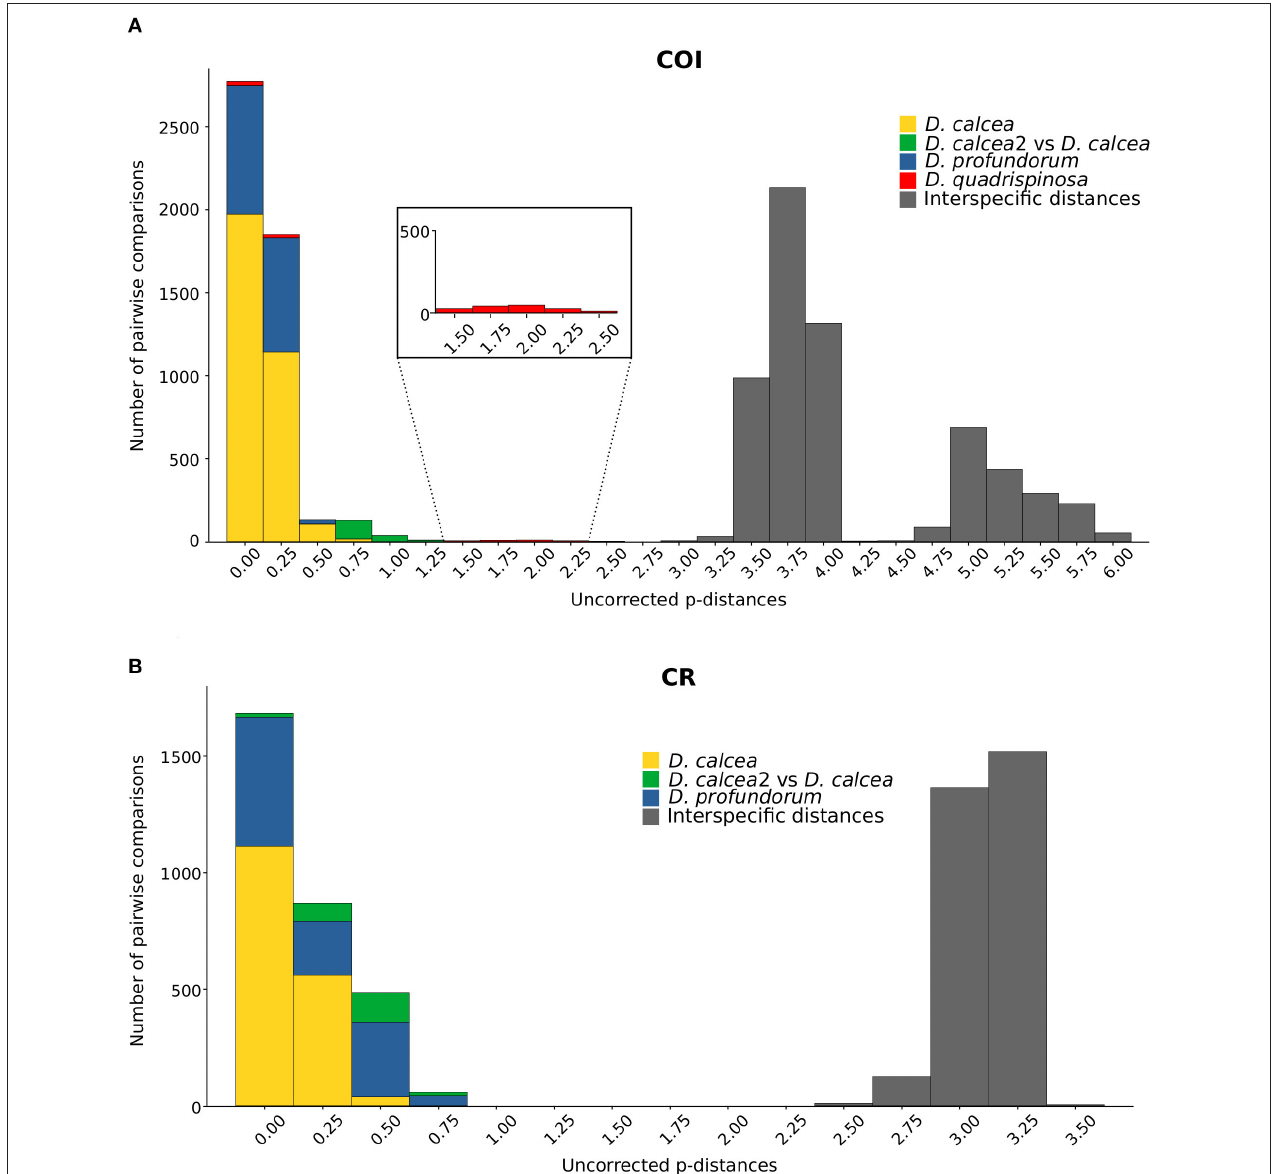
FIGURE 3 | Histograms with genetic uncorrected p-distances for COI (A) and CR (B) . Square in (A) is a